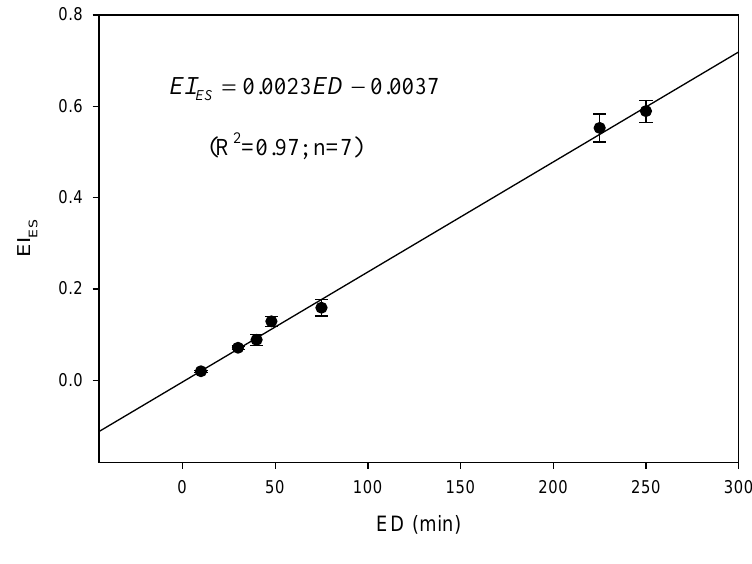
Figure 2. The relationship between EI corresponding exposure duration (ED).